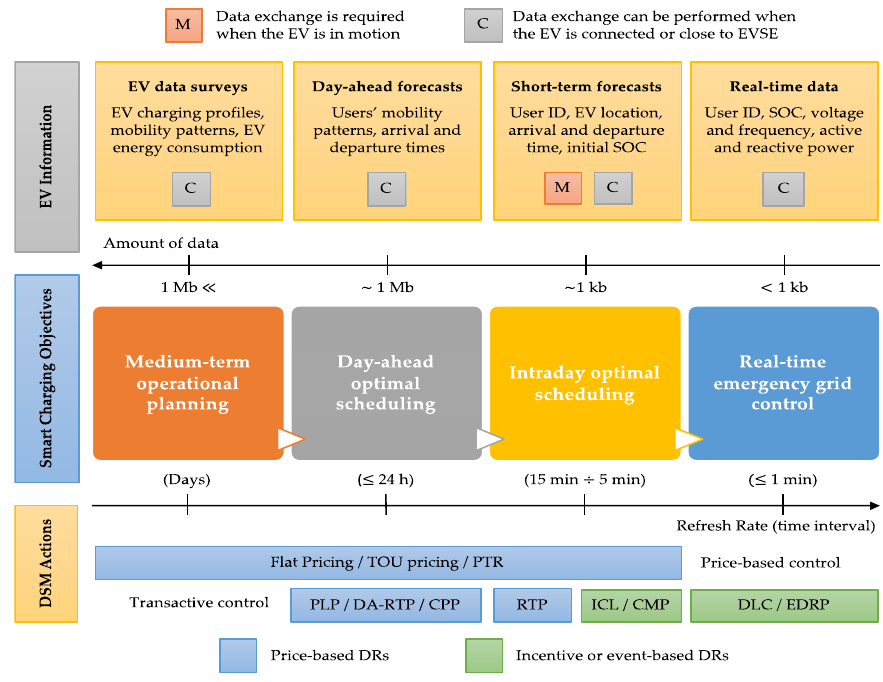
Figure 6. Schematic representation of the communication requirements of DSM schemes for